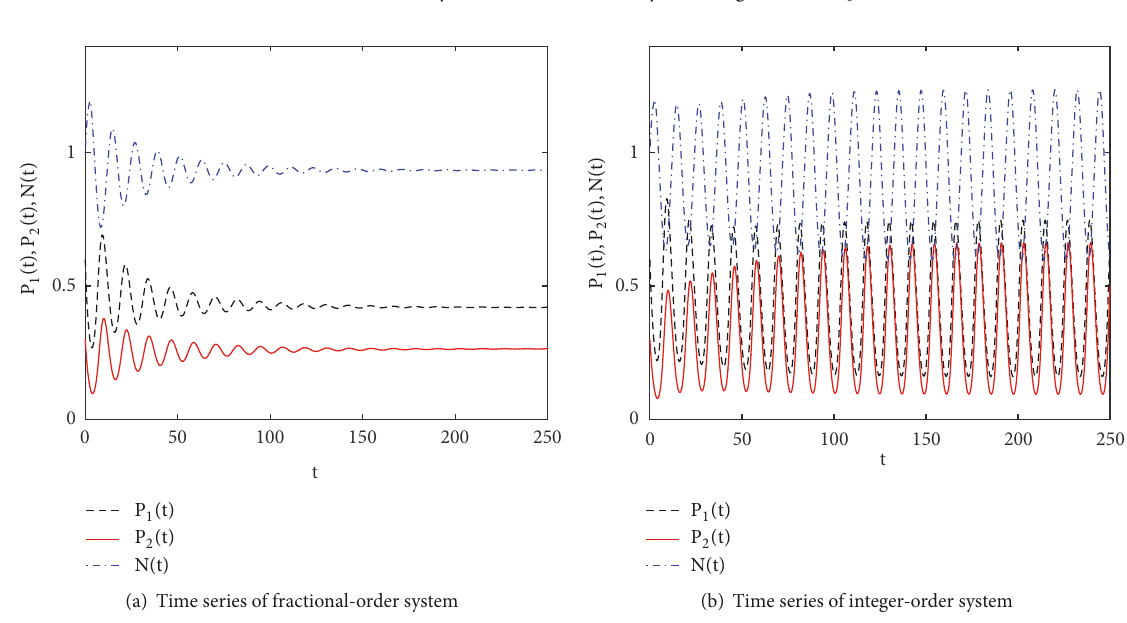
Figure 3: 𝐸 ∗ of fractional-order system is stable; 𝐸 ∗ of integer-order system is